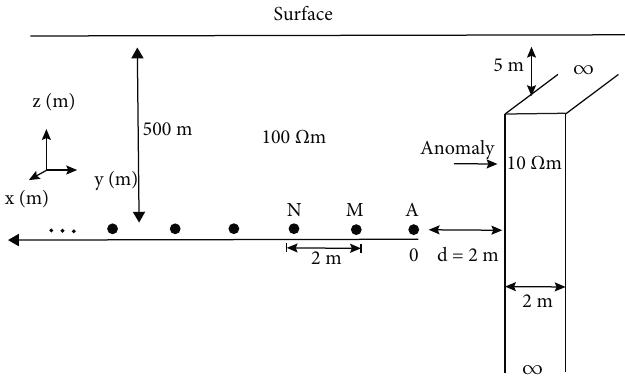
Figure 1: Schematic diagram of the whole-space slab model.